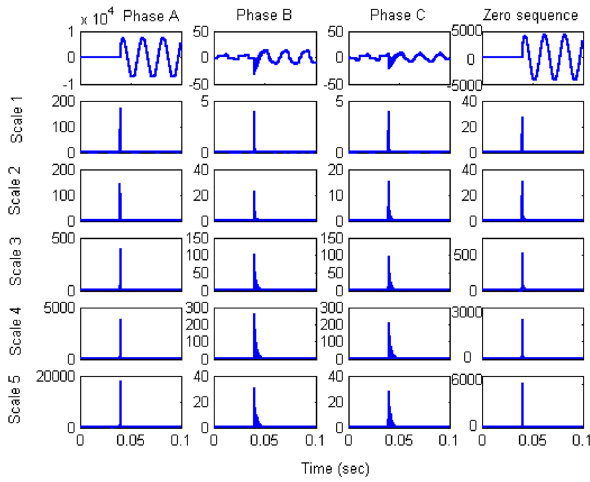
Figure 7. Coefficients of three-phase and zero-sequence differential currents under phase A winding-to- ground fault on high-voltage (primary) winding at 10% of the